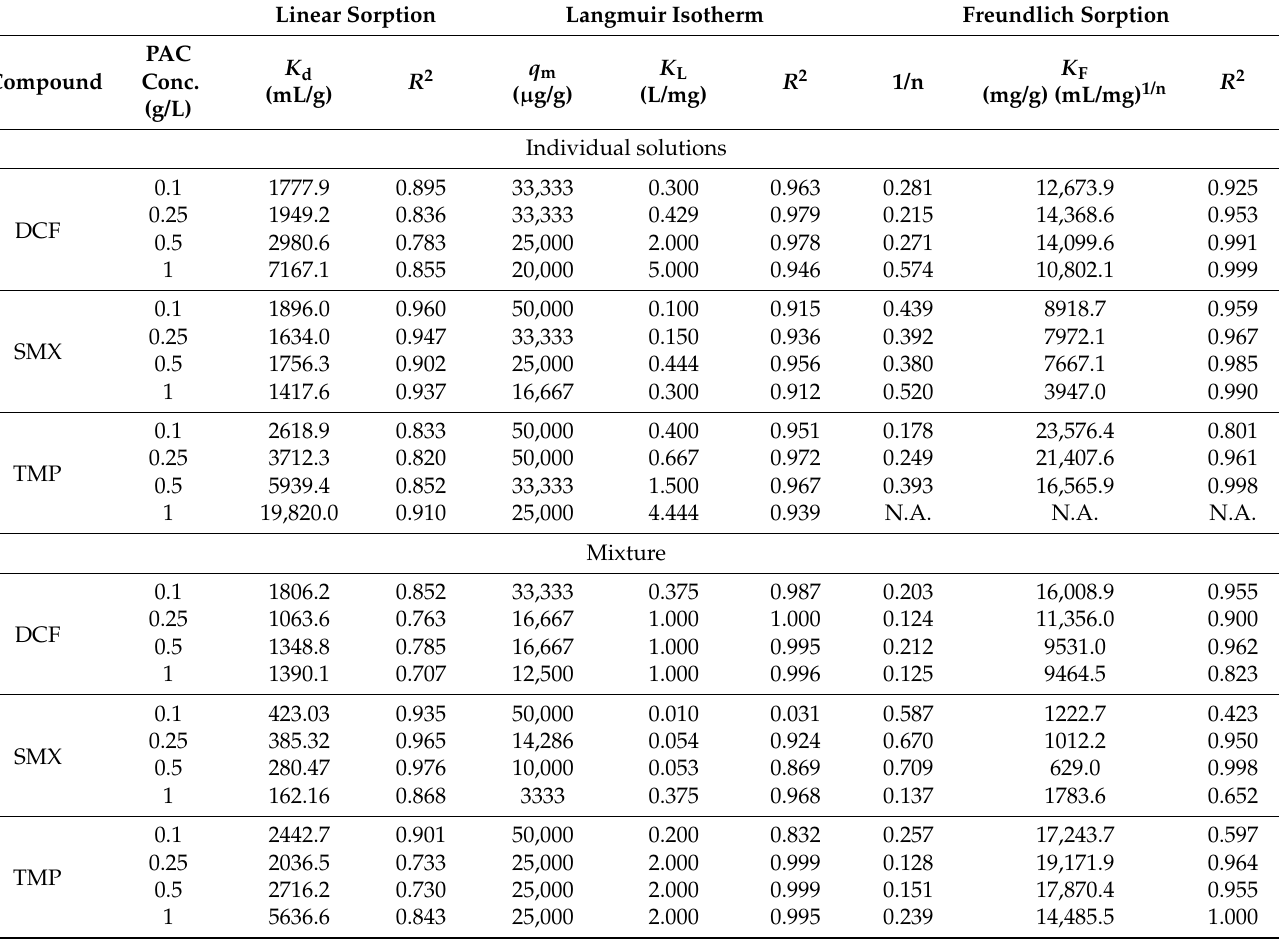
Table 3. Distribution coefficient ( K d ), Langmuir and Freundlich isotherm constants obtained in individual solutions of each pharmaceutical (DCF, SMX and TMP) and the mixture of the three pharmaceuticals in ultra-pure water. N.A. (not applicable) indicates that the parameters could not be obtained, as the residual concentration found in the liquid phase was too low to conduct the